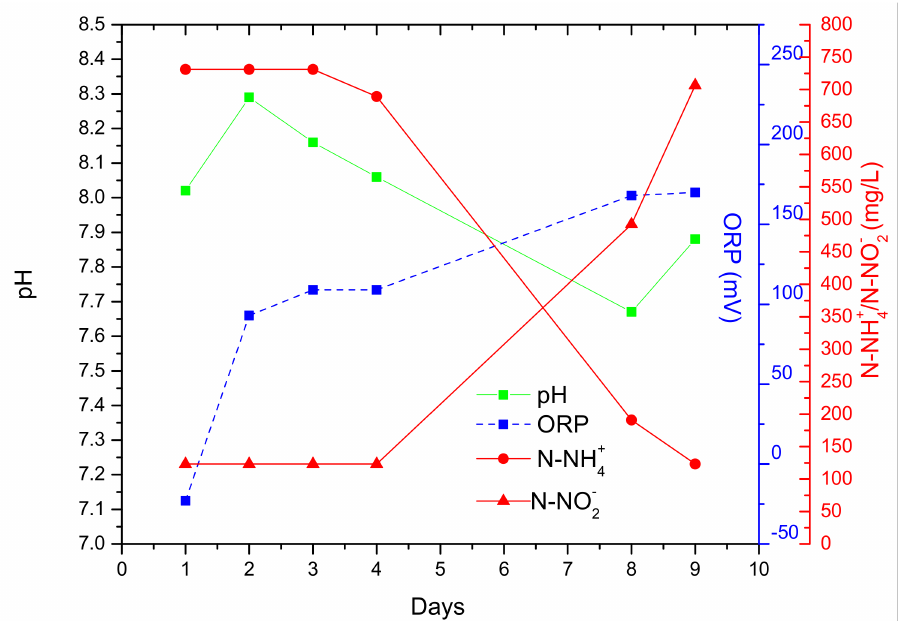
Figure 6. Evolution of nitrification process and the relation to ORP. Linear non-equilibrium thermodynamics was implemented to simulate the biological nitrification process and compared it to ammonium oxidation. Empirical variation in the ORP was obtained in measuring changes in NH 4+ , NO 3 − and NO 2 − concentrations ORP. The results indicate acceptable correlations on molarities of electrons transferred. The simulation model was completed based on the Nernst equations for ammonium oxidation, including a mathematical model to evaluate the influence of variables as pH, DO, and NH 4+ . The results can be interpreted as a correct qualitative description of this novel model concept.